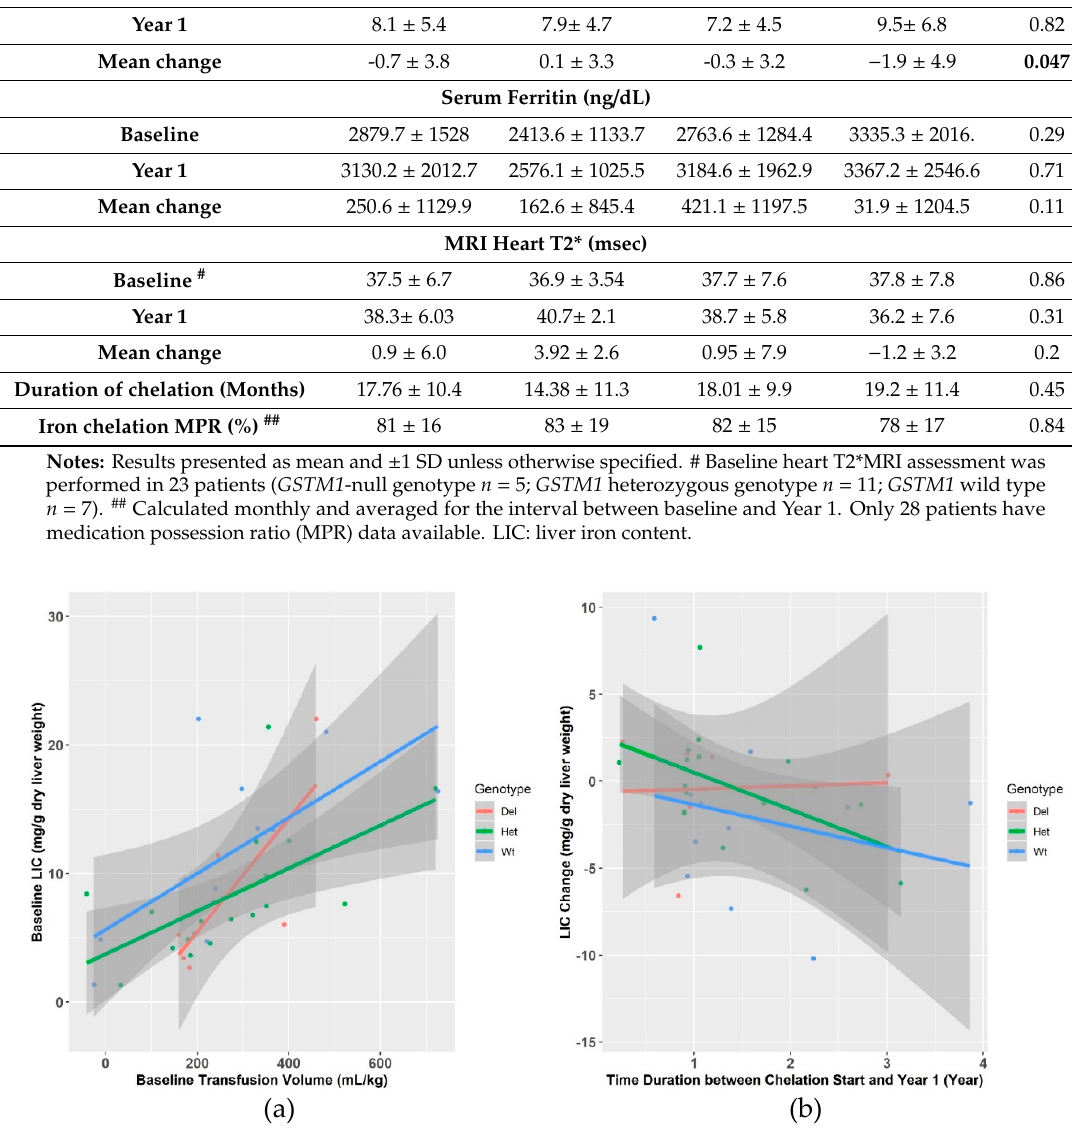
Figure 1. Liver iron content (LIC) R2*MRI differences according to glutathione S-transferase M1 (GSTM1 ) genotype groups. ( a ) LIC increases with transfusion burden. Baseline LIC is variable for similar transfusion burden and not significantly different by GSTM1 genotype ( p = 0.09). ( b ) During iron unloading therapy (chelation and therapeutic phlebotomy), patients with homozygous GSTM-1